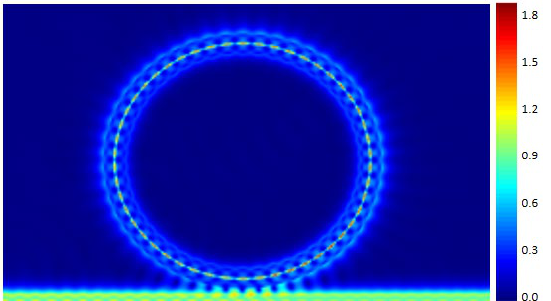
Figure 5. Mode field distribution of ASGMRR as a whole.